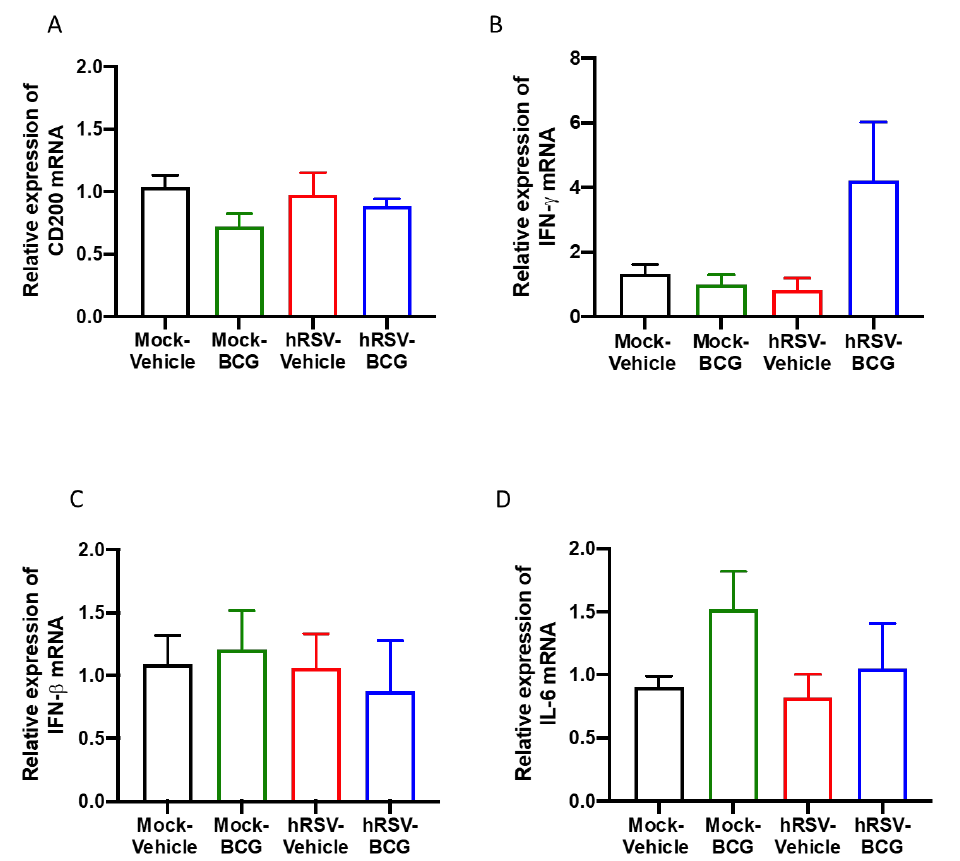
Figure 4. Determination of the relative expression of immunomodulatory molecules and cytokines in infection with Bacillus Calmette-Guerin (BCG) at 10 days post-human respiratory syncytial virus (hRSV)-infection. Quantification by real-time quantitative reverse transcription polymerase chain reaction (RT-qPCR) of OX-2 glycoprotein membrane ( cd200 ) at day 10 post-infection ( A ), interferon-gamma ( ifn- γ ) ( B ), interferon beta ( ifn- β ) ( C ), and interleukin (IL)-6 ( D ). Data are shown as means ± SEM of three independent experiments with 3 – 4 animals per group. One-way ANOVA was performed with a post-hoc Tukey test.